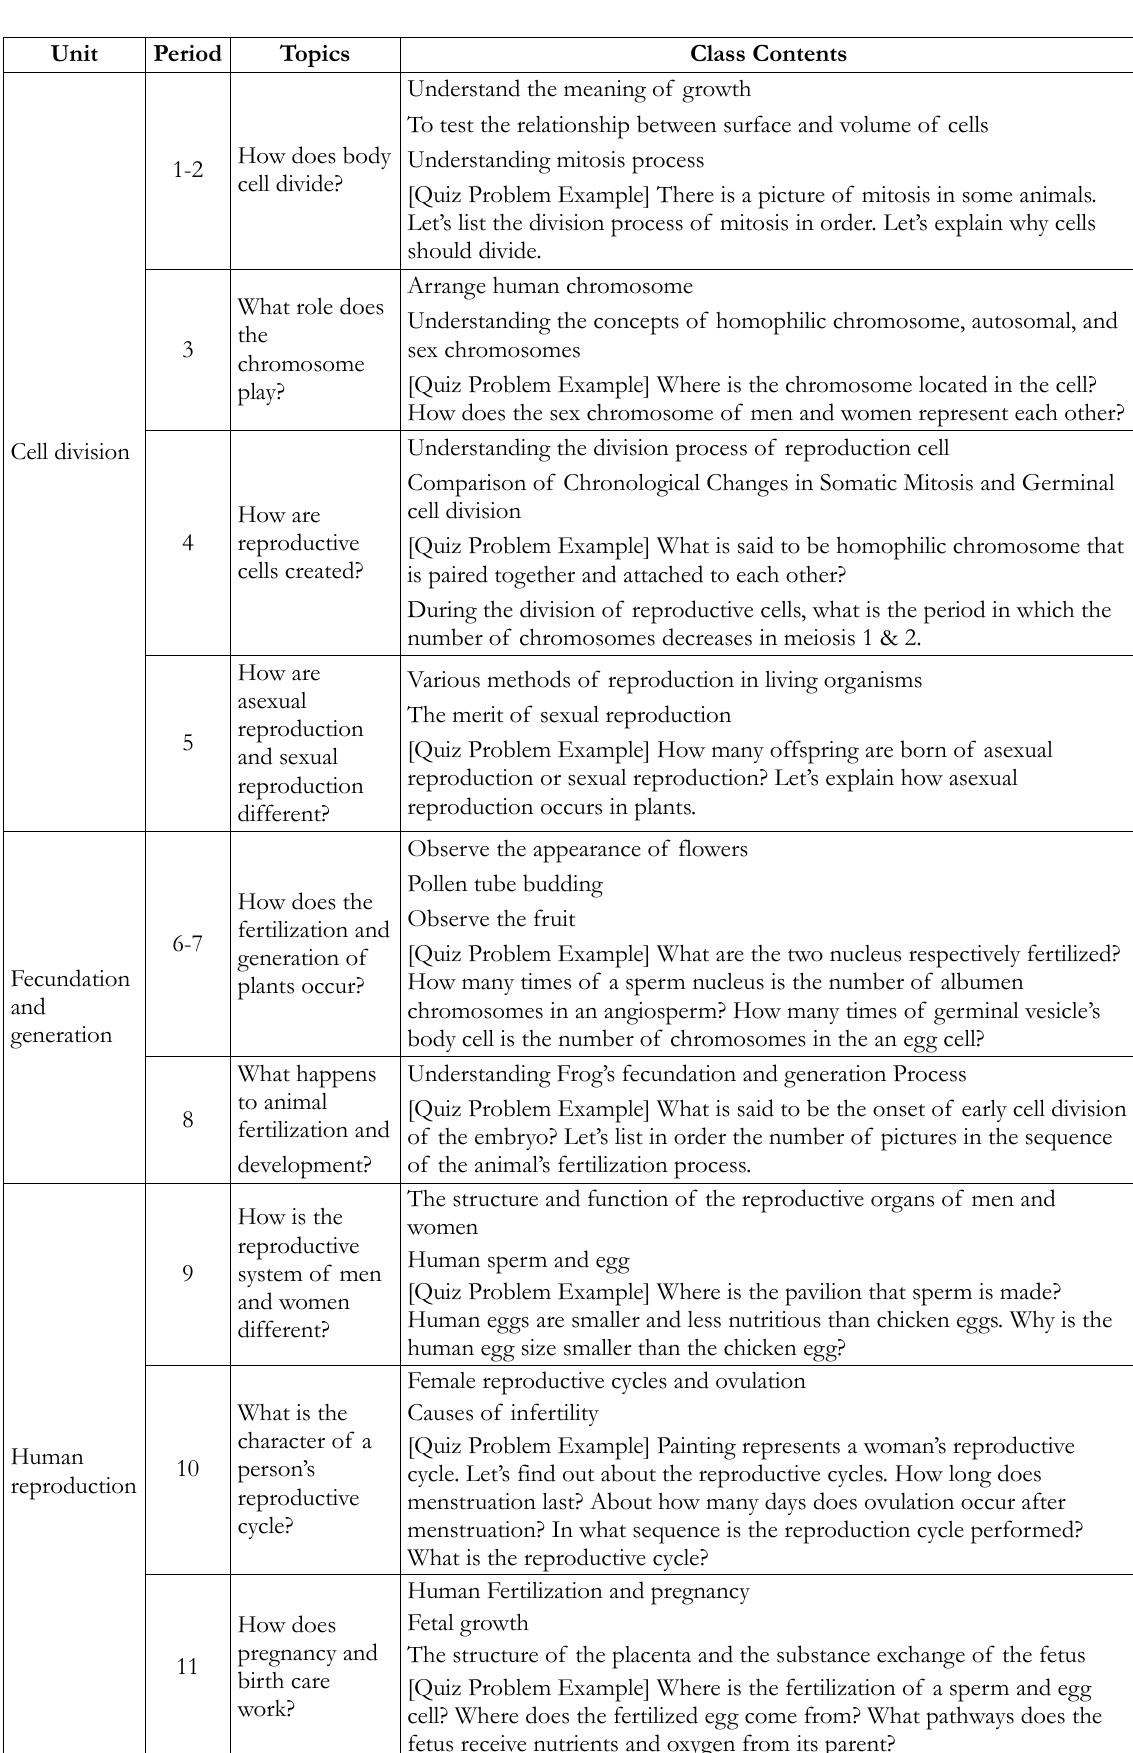
Table 2. Science Class Contents Applying STAD Cooperative